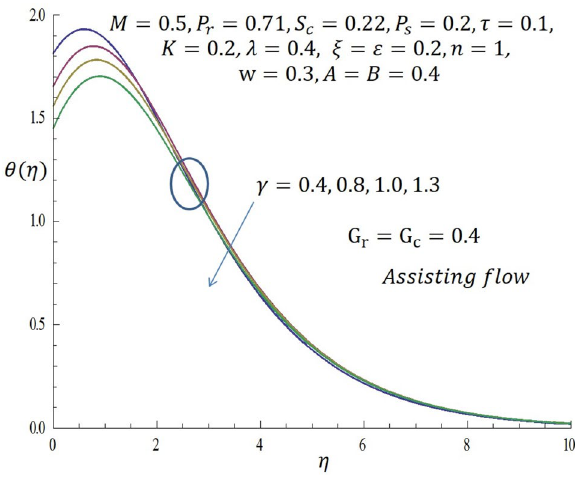
Figure 13. Effect of γ on temperature profile when G r = G c = 0.4 .